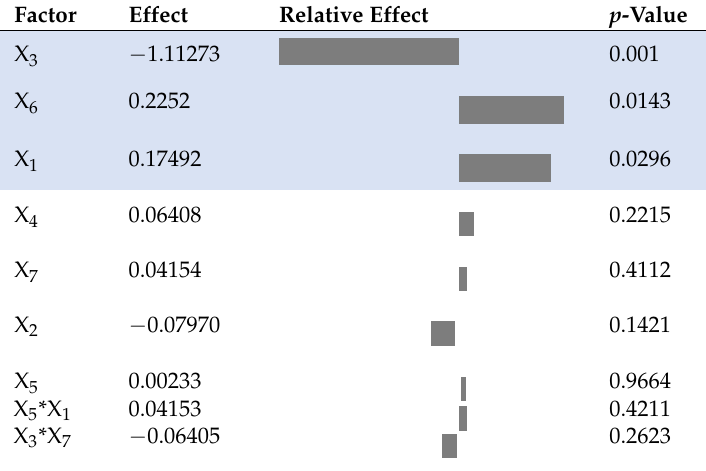
Table 5. Identification of the statistically significant factors during a screening process using a Fractional Factorial Design. The table depicts the effect, positive or negative and p -value for seven factors examined (labelled X 1 to X 7 respectively). The effect of each factor, positive (+) or negative ( − ) is identified during the analysis stage using the statistical formula imbedded in DoE software used (JMP in this example). Interaction effects are also identified (e.g., X 5 *X 1 and X 3 *X 7 ; where * indicates an interaction). The p -value of each factor is also shown, at the significance level of 0.05. In this example, the highlighted factors, (X 3 , X 6 , X 1 ), were identified as the most influential based on their high effects ( − 1.11273, 0.2252, 0.17492) and p -values < 0.05 (0.001, 0.0143, 0.0296). Thus, only factors X 3 , X 6 and X 1 are statistically significant at the level of 0.05, with X 3 having a negative effect while X 6 and X 1 have positive effects. Other factors, X 2 , X 4 , X 5 , X 7 and interactions X 5 *X 1 , X 3 *X 7 are not statistically significant.